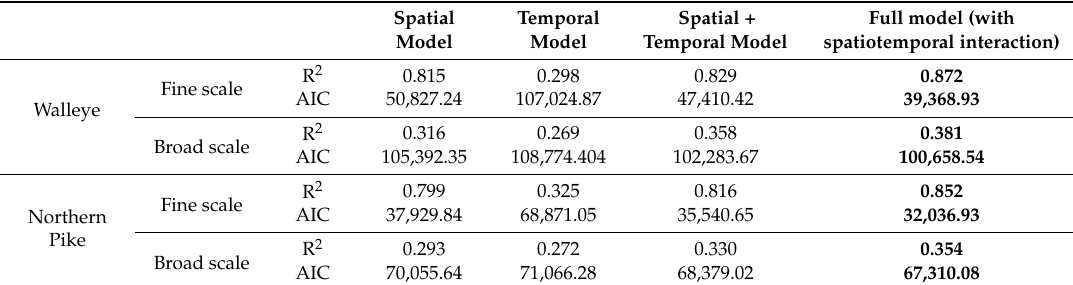
Table 2. Summary of model fit for Walleye and Northern pike across all the four pre-defined LMEMs (See Table 1 for details on model structure) that capture the effects of space and time at fine and broad scale of analysis. The best-fitting model with lowest AIC and highest R 2 values in each category is highlighted in